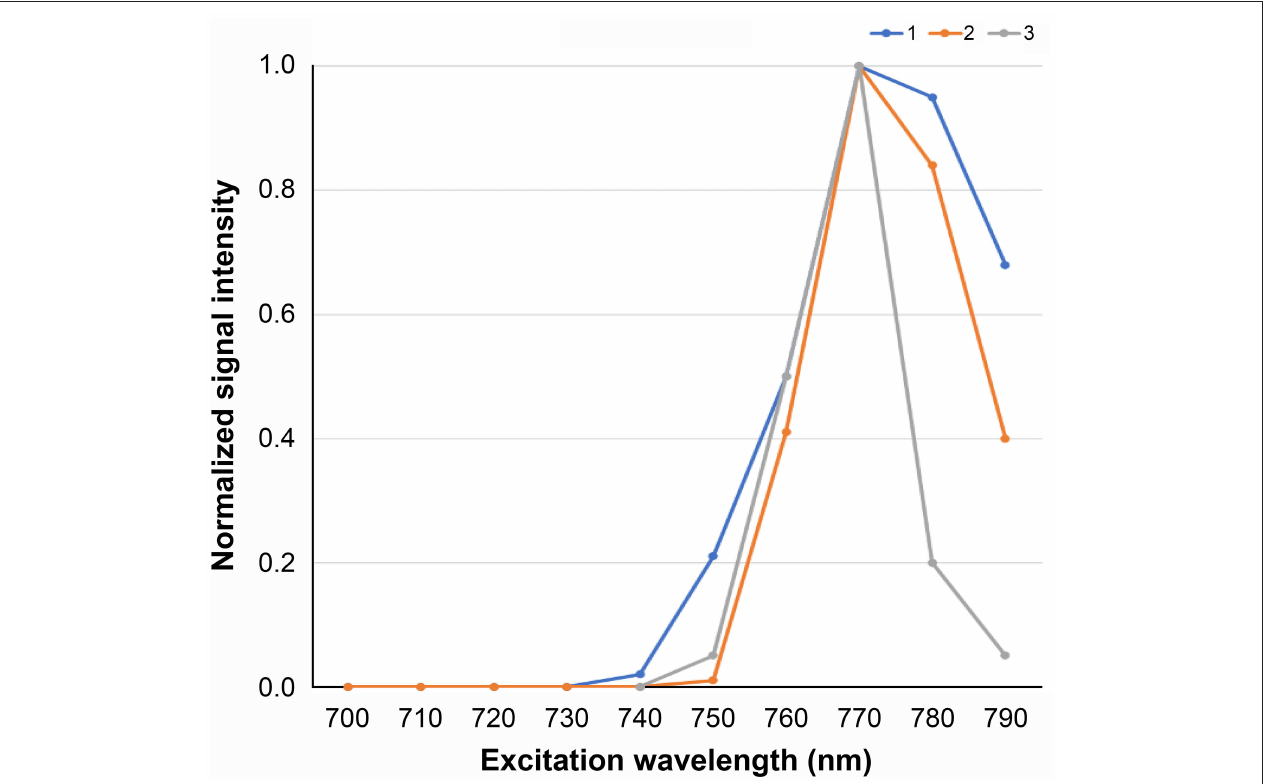
FIGURE 2 | Autofluorescence intensity characteristics for the three parathyroid glands. The optimum excitation wavelength for the parathyroid gland to autofluorescence absorbance wavelength of 800–850nm was estimated to be